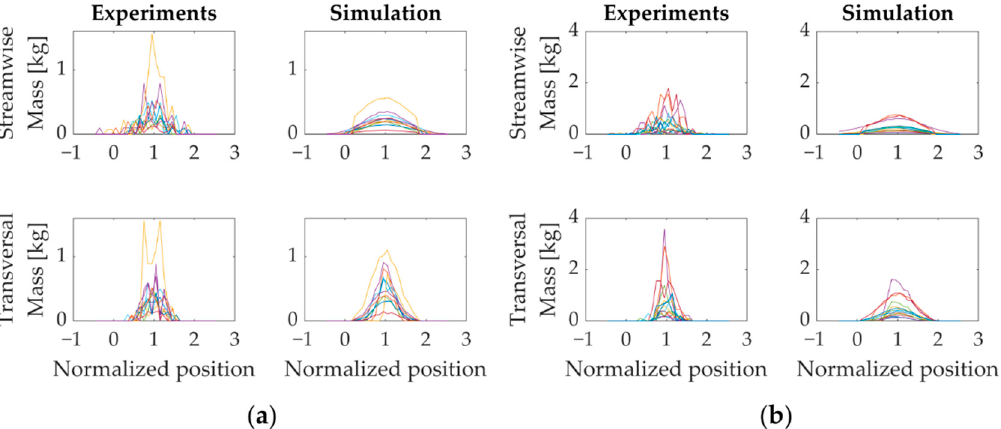
Figure 14. ( a ) Wood mass along the streamwise and transversal axis of the target area for the S-shaped flume. ( b ) Wood mass along the streamwise and transversal axis of the target area for the S-shaped flume with narrowing.